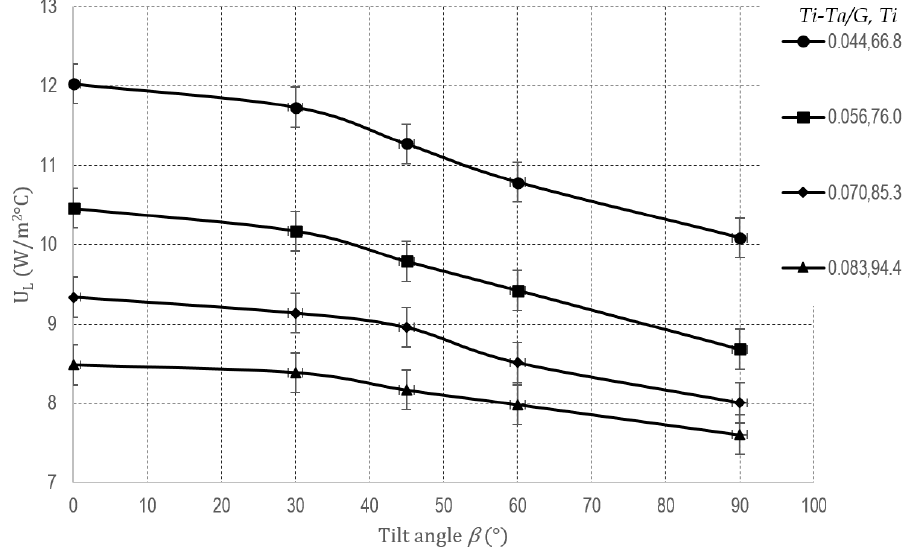
Figure 3. U L vs. β , for variable ( T i − T a )/ G at its corresponding T p , at Q u ( β ) > 0.